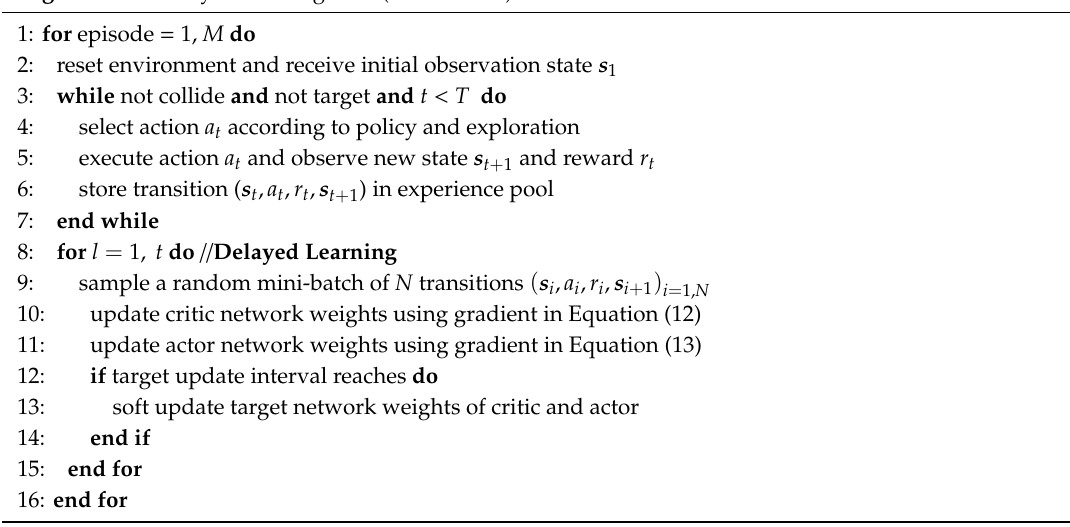
Algorithm 1 : Delayed learning trick (with DDPG)